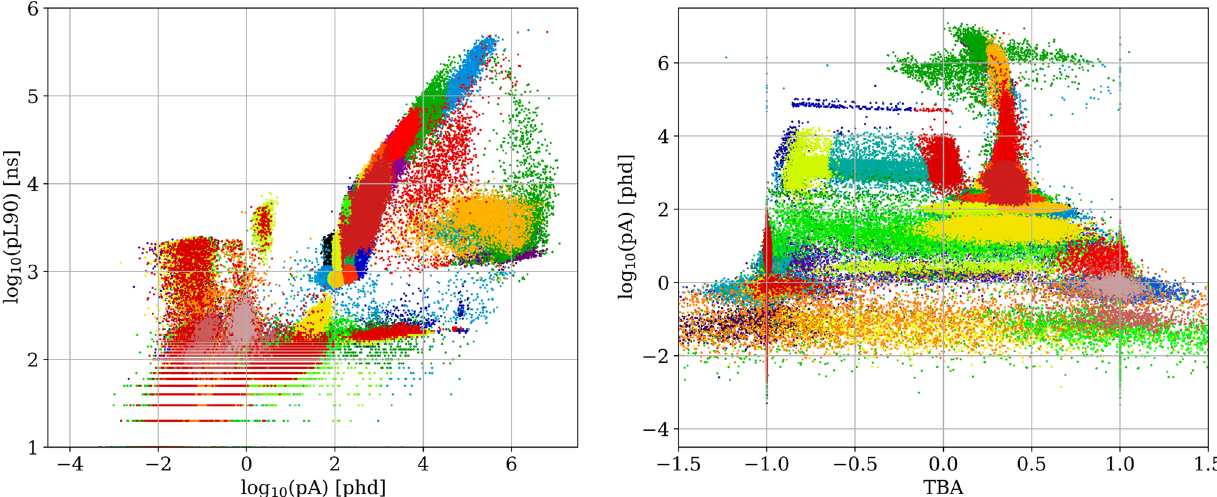
Fig. 3 Scatter plots of the GMM components for pulse area ( pA ) vs pulse length ( pL90 ) RQs (left) and top-bottom asymmetry ( TBA ) vs pulse area RQs (right). The size and density of the 67 components vary